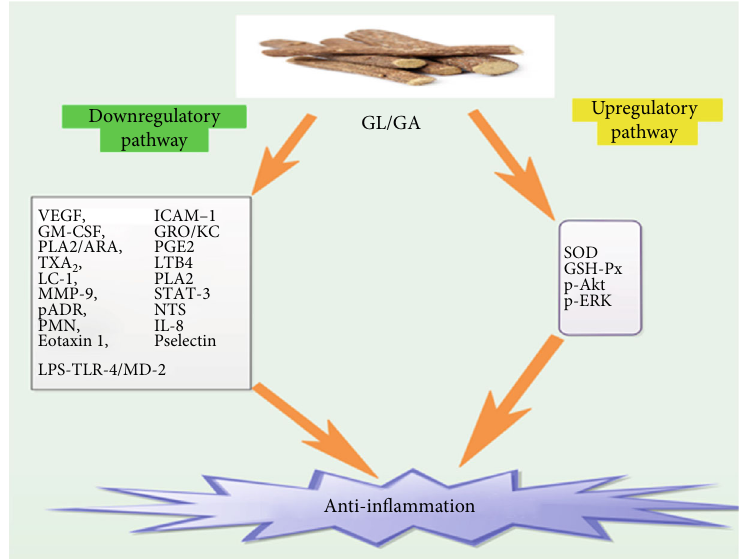
Figure 1: Shows a comprehensive down and upregulatory pathways via which GL and GA elicits anti-in fl